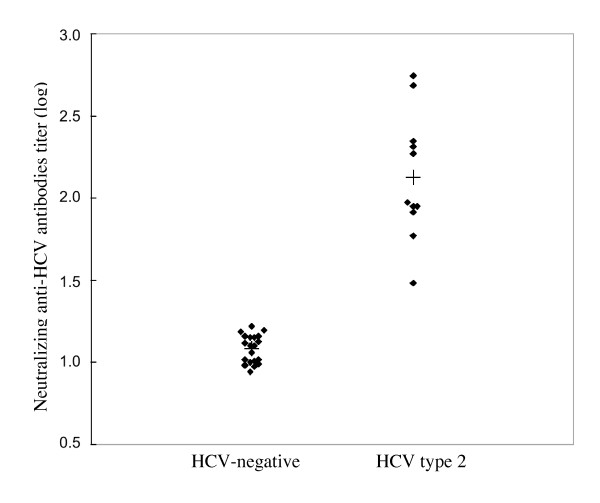
Neutralization of HCVcc JFH-1 in infected Huh-7 cells for two distinct populations of samples, characterized by the presence (HCV genotype 2) or absence (HCV-negative) of anti-HCV antibodies.